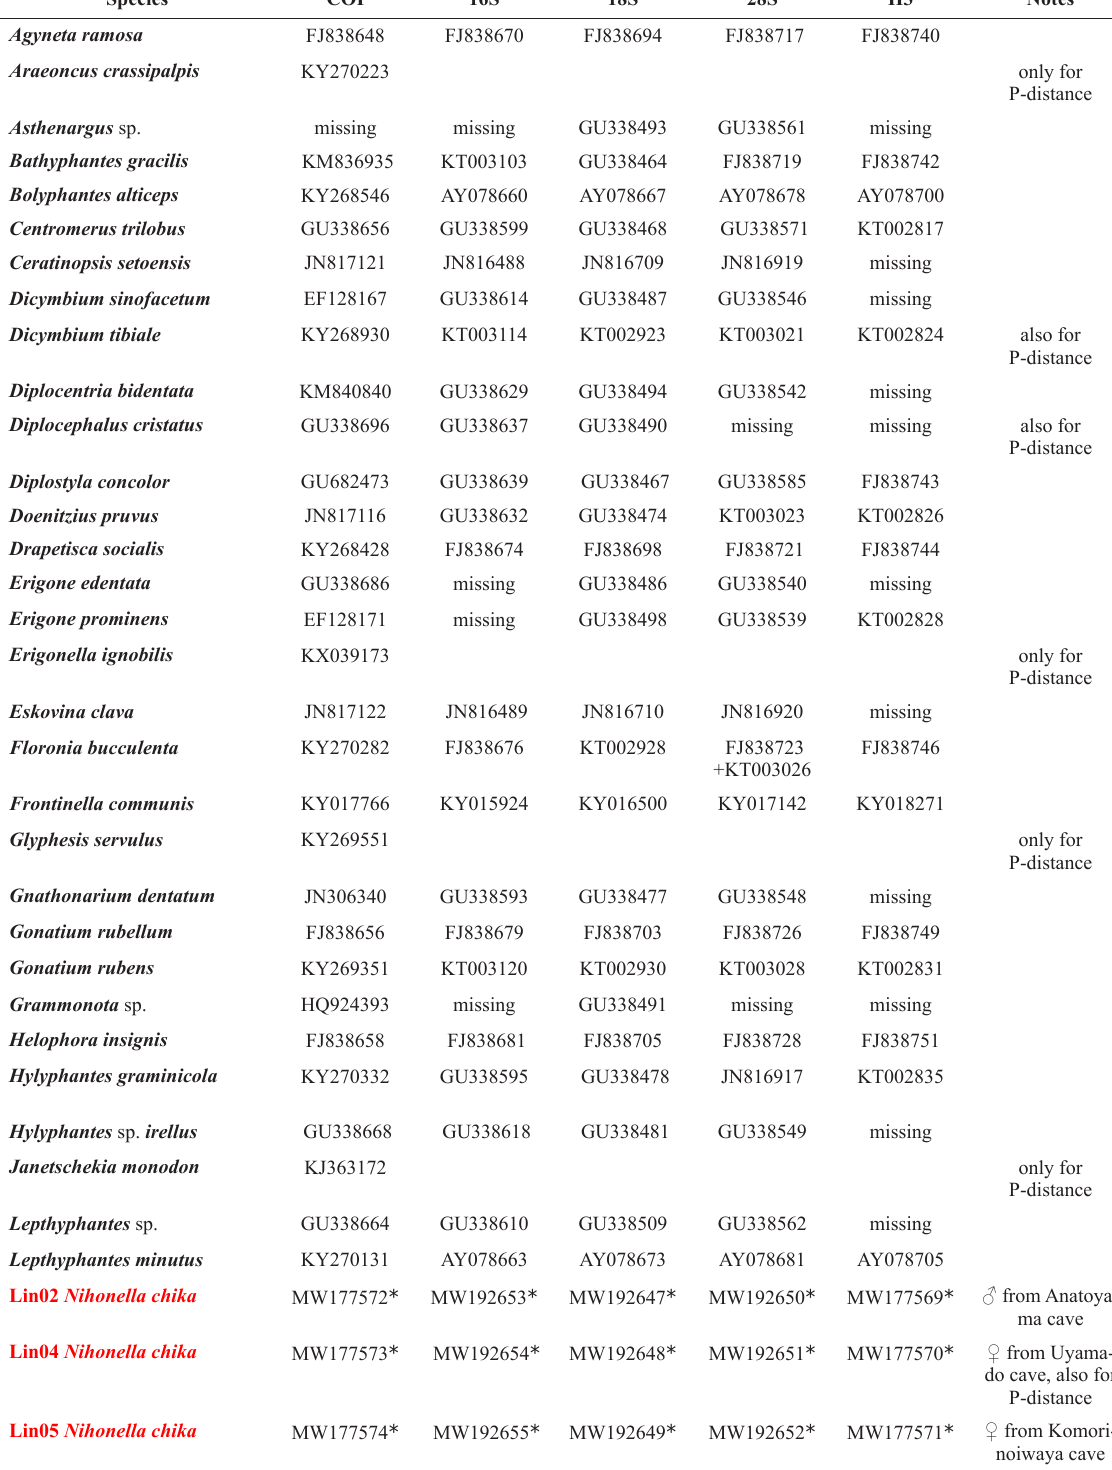
Table 1. List of the species, gene fragments and related GenBank accession codes used to reconstruct the phylogenetic tree and in P-distance analyses. The new genus is highlighted in red color, asterisks refer to new